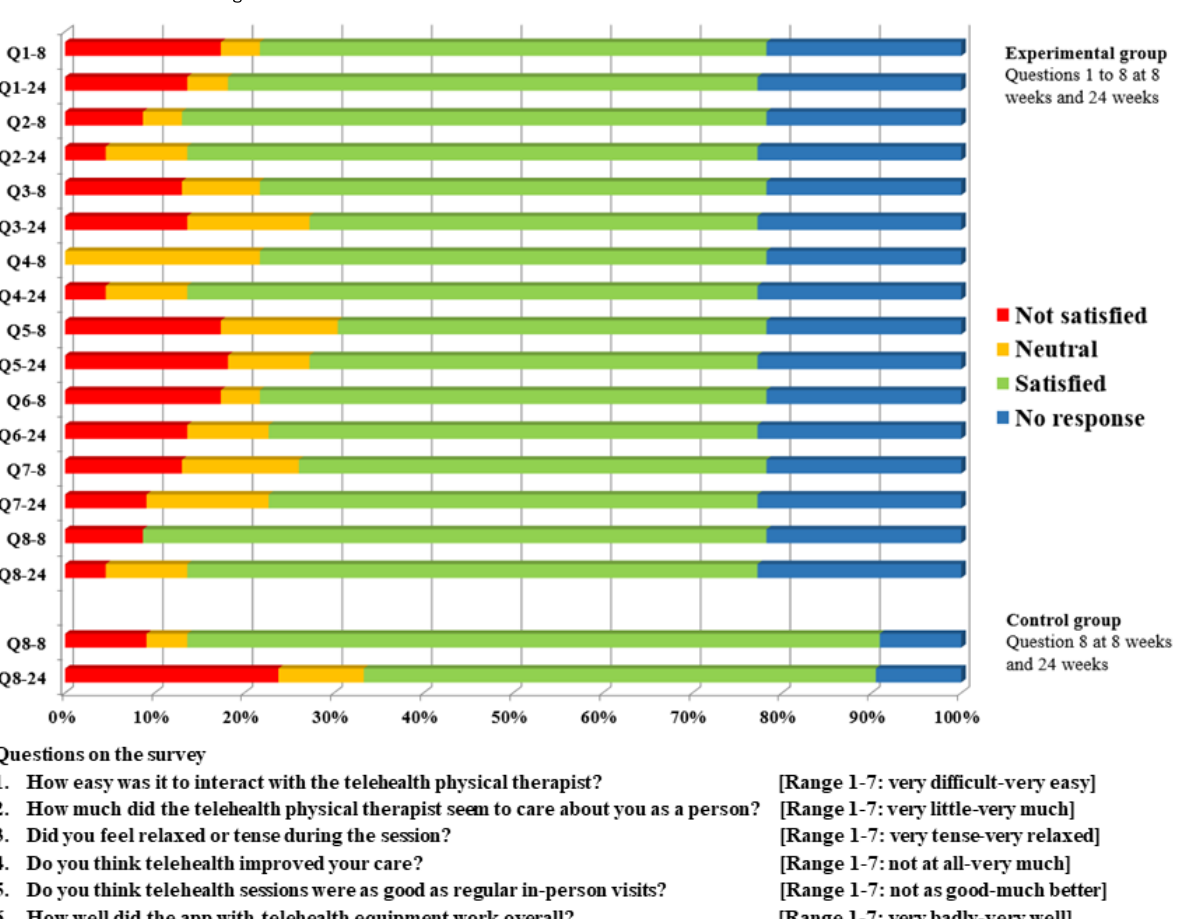
Figure 3. Percentage responses in categories unsatisfied (red), neutral (orange), satisfied (green), and no response (blue) from the survey completed by the experimental and control groups. The experimental group answered 7 questions related to app with telemedicine use, feasibility, and ease of interaction with the telehealth physical therapist. The eighth question was answered by both groups and pertained to their rating of satisfaction with the overall physical therapy experience. The answer options ranged from scores 1 to 3 (being not satisfied [scoring very unsatisfied to a little unsatisfied]), score 4 (neutral), or scores 5 to 7 (satisfied [scoring a little satisfied to very satisfied]) or no response. The question and answer options for each question are detailed at the bottom of the